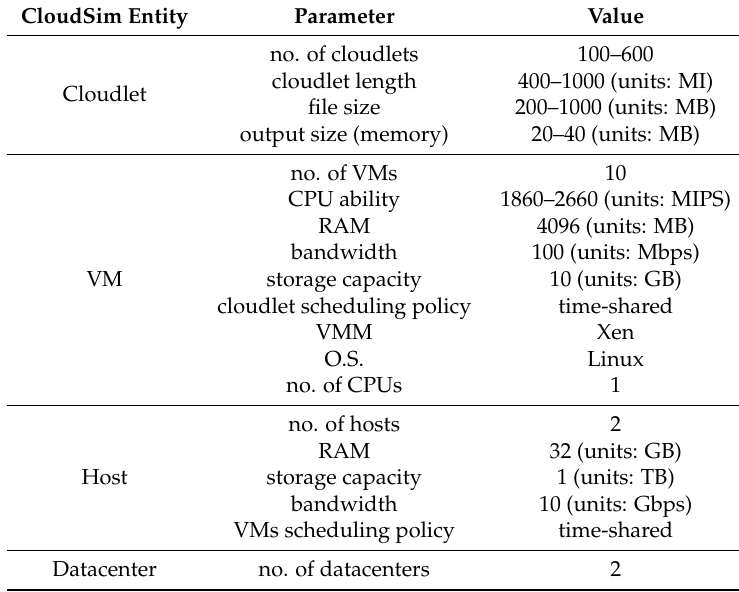
Table 7. CloudSim environment configuration for simulations with an artificial data set.